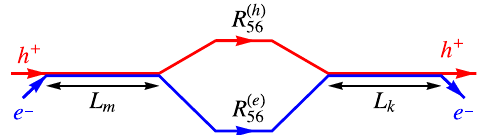
FIG. 1. Schematic of a simple MBEC